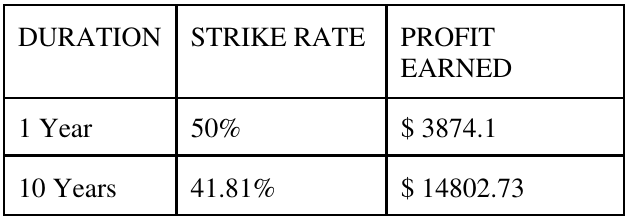
Table 6: Gold Cross Evaluation